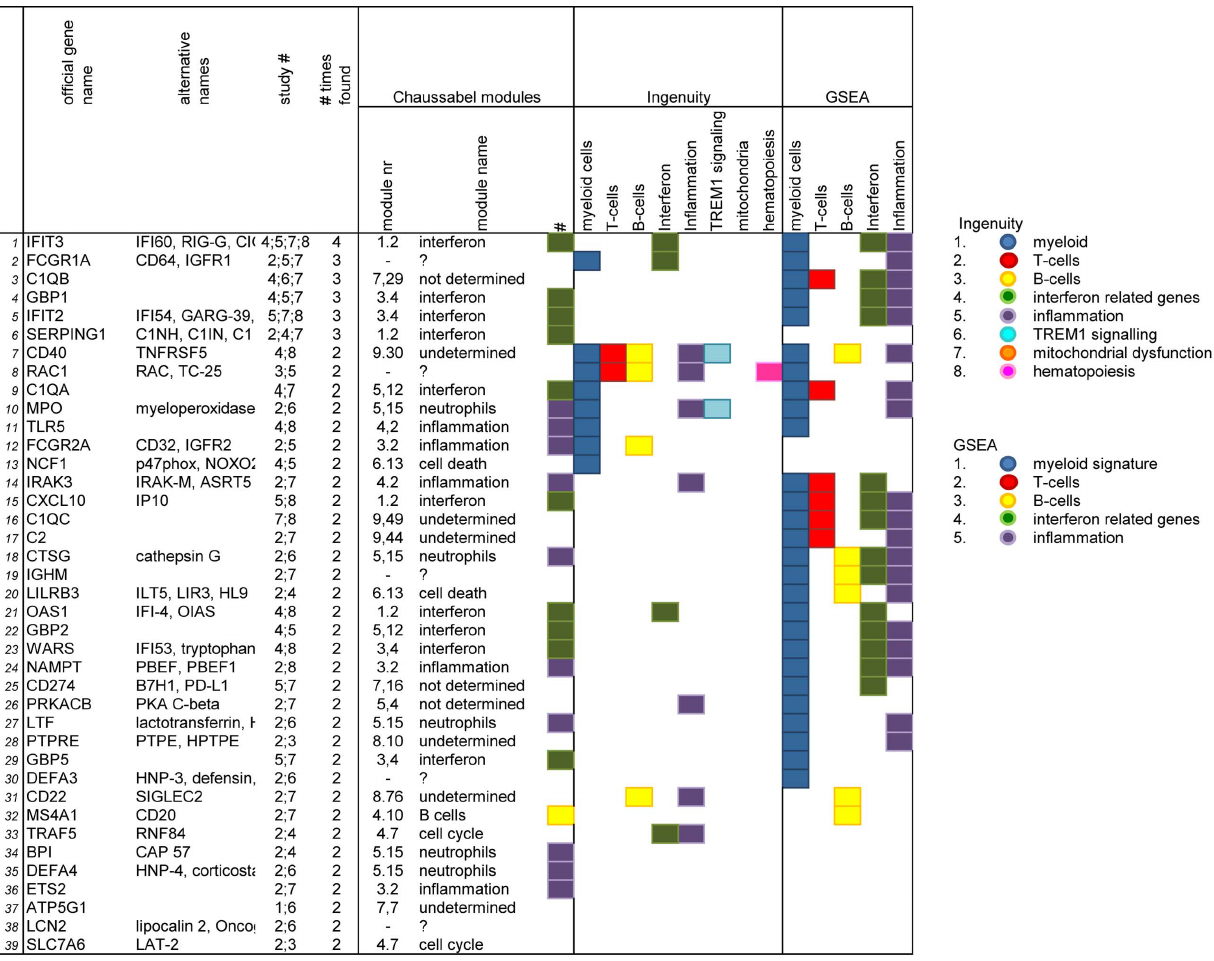
Figure 3. Genes identified by more than 1 independent study. Genes identified by more than 1 independent global genome-wide gene expression analysis. Manuscript numbers refer to Table 2. Classification into modules, functional groups according to Ingenuity and GSEA was performed according to Tables 3 & 4 and identical to Table S1. doi:10.1371journal.pone.0073230.g003